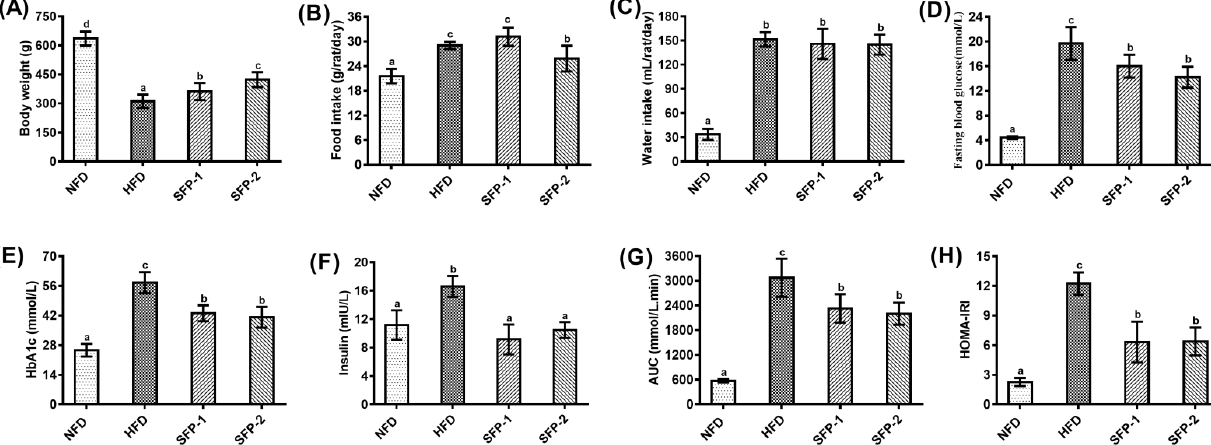
Figure 2. Effects of SFPs on body weight ( A ), food intake ( B ), water intake ( C ), fasting blood glucose level ( D ), HbA1c ( E ), insulin ( F ), AUC ( G ) and HOMA-IRI ( H ) in diabetic rats. The different letters represent significant difference ( p <